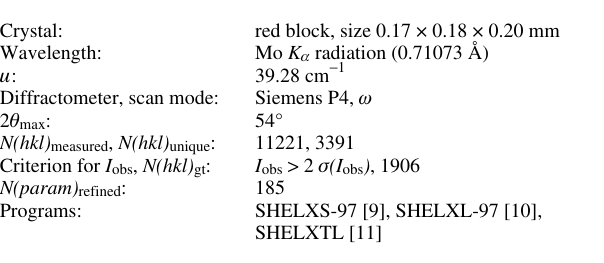
Table 1. Data collection and handling.